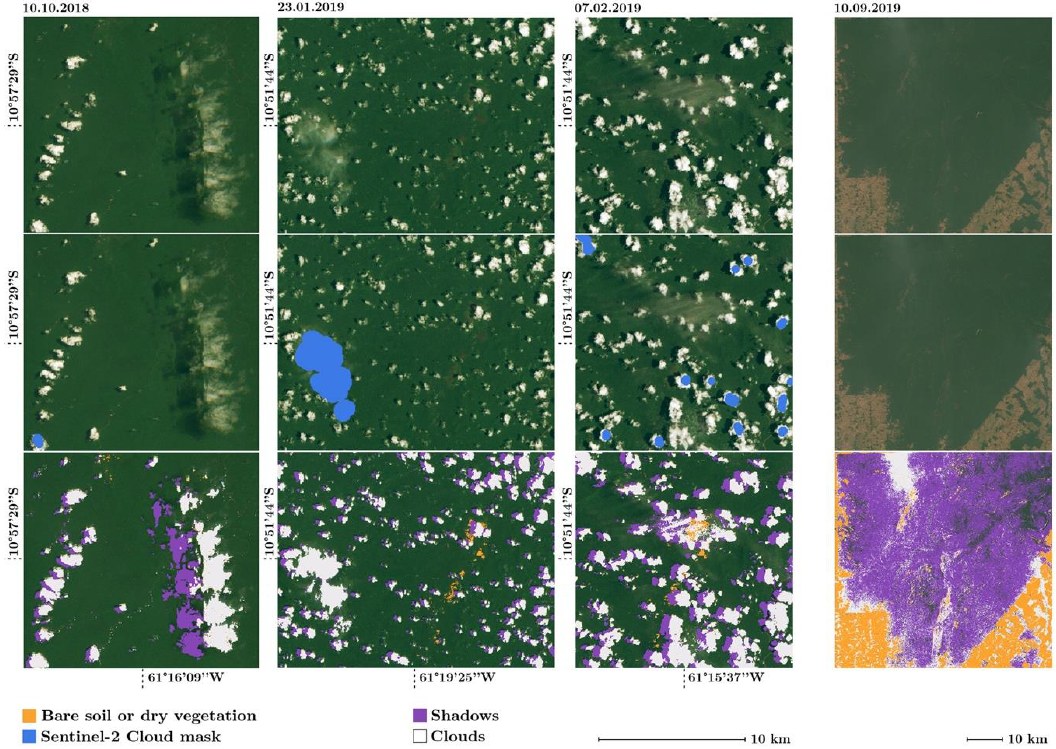
Figure 10. Original unclassified Sentinel-2 image in true colors (upper row), Sentinel-2 cloud mask (middle row) and results of our cloud, shadow, and bare soil land classification (lower row).